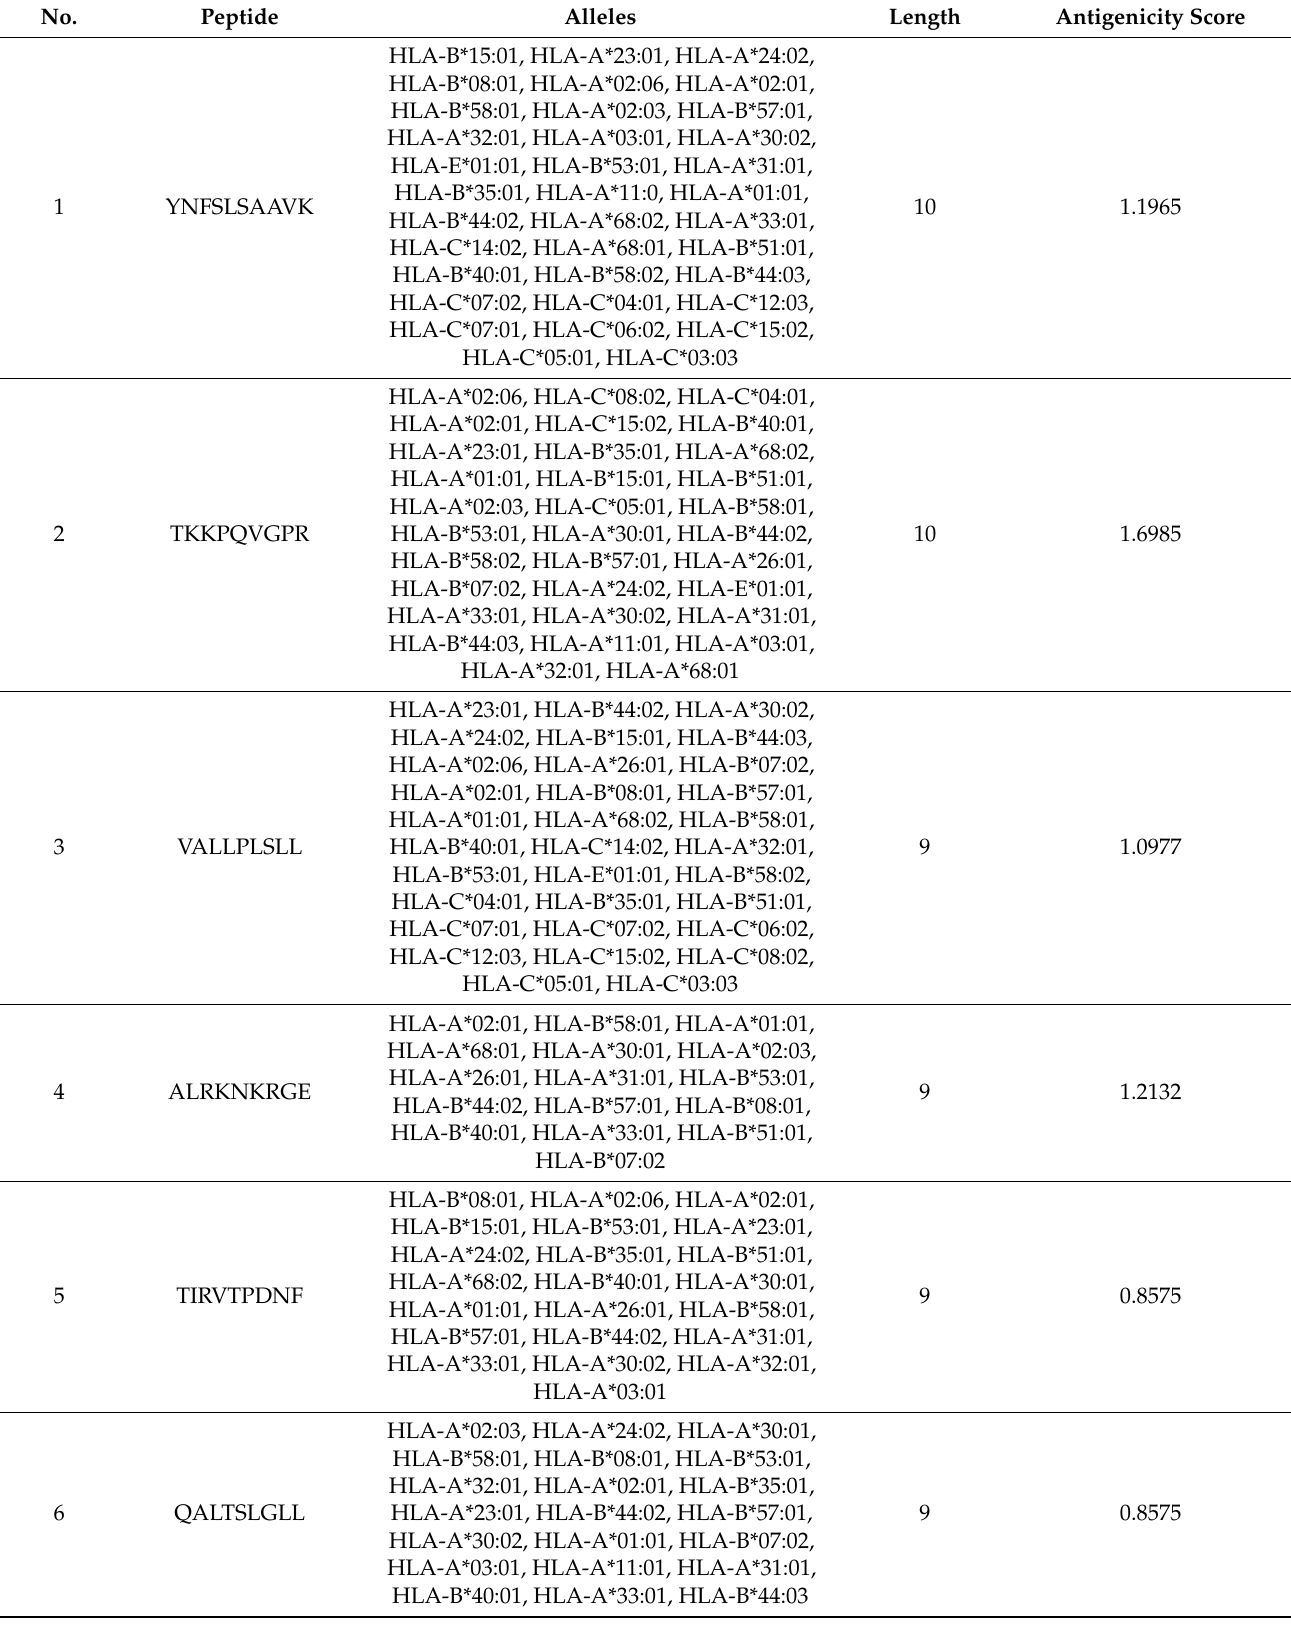
Table 2. Predicted MHC-I restricted epitopes computed from